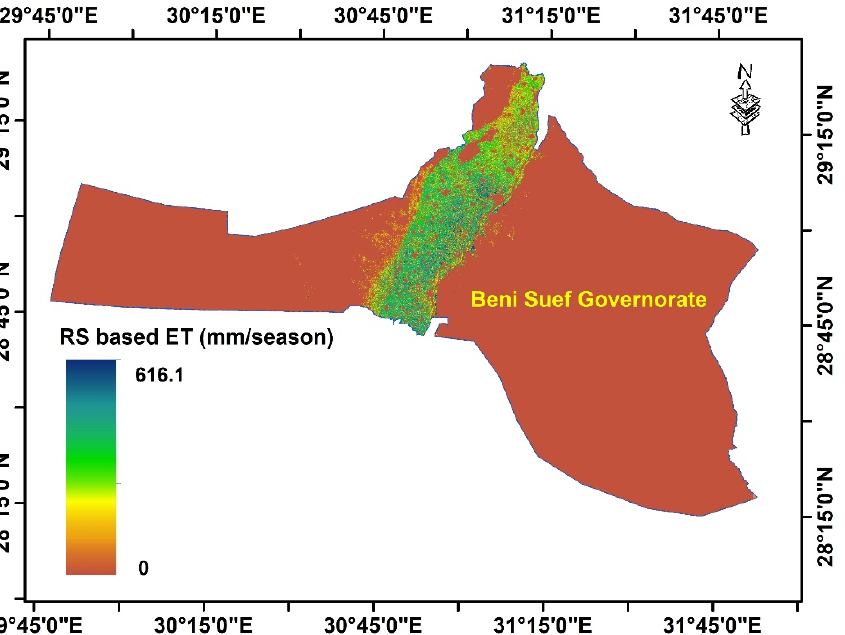
Figure 9. Accumulated remote sensing-based ET during the winter season from 21 November 2020 to 30 April 2021.